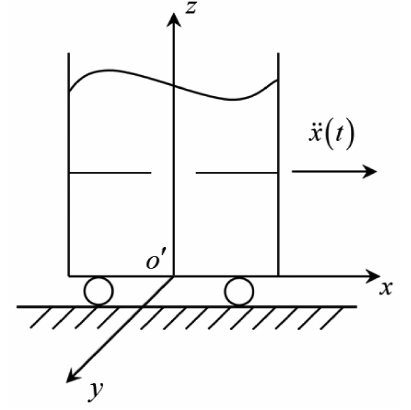
Fig. 3. Container’s